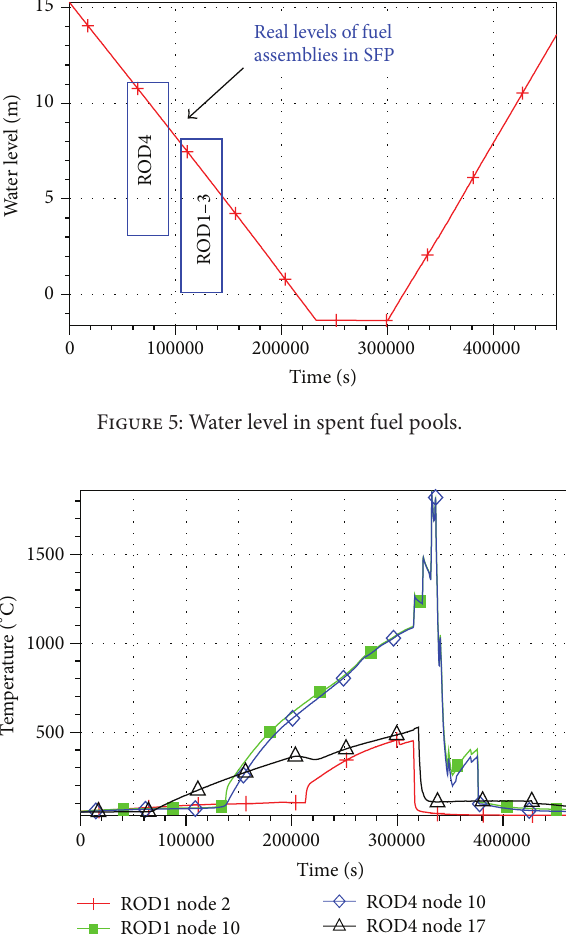
Figure 6: Fuel temperature in SFAs with different storage period at different elevations: node 2—at elevation 1.17m, node 10—at elevation 5.64m, node 17—at elevation 10.82 m (elevations from the bottom of